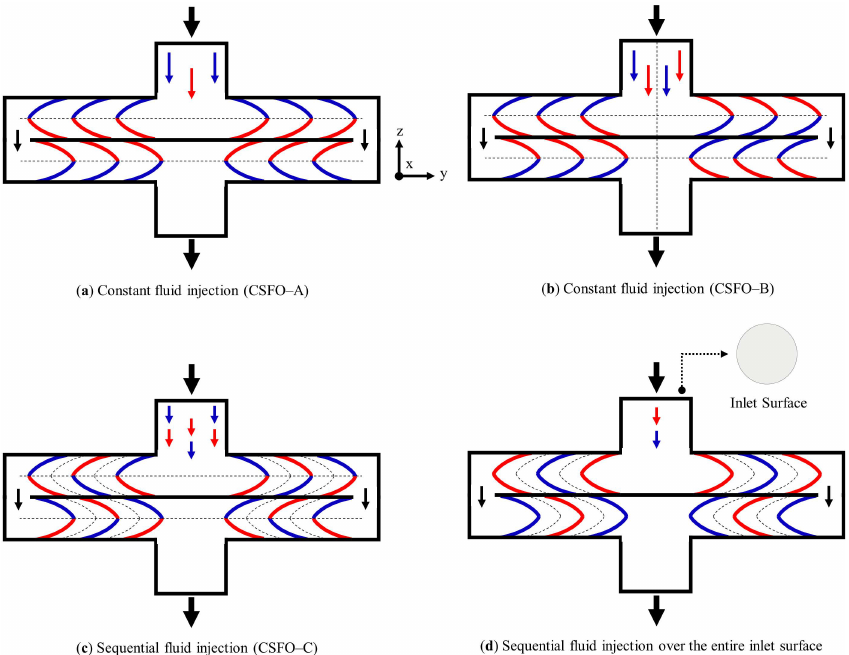
Figure 3. The distribution of injected fluids in each mixing unit of the micromixer configurations ( a ) CSFO–A; ( b ) CSFO–B; and ( c ) CSFO–C. ( d ) The distribution of fluids in a single mixing unit when the entire inlet surface is used to inject fluids sequentially. The dashed lines and curves show the contact surfaces formed between different fluids. Red and blue colors represent the mixing fluids injected from inlet surface(s). Black arrows show flow